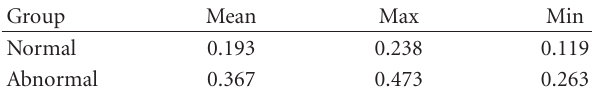
Table 1: Error estimation for identification of HR baroreflex.